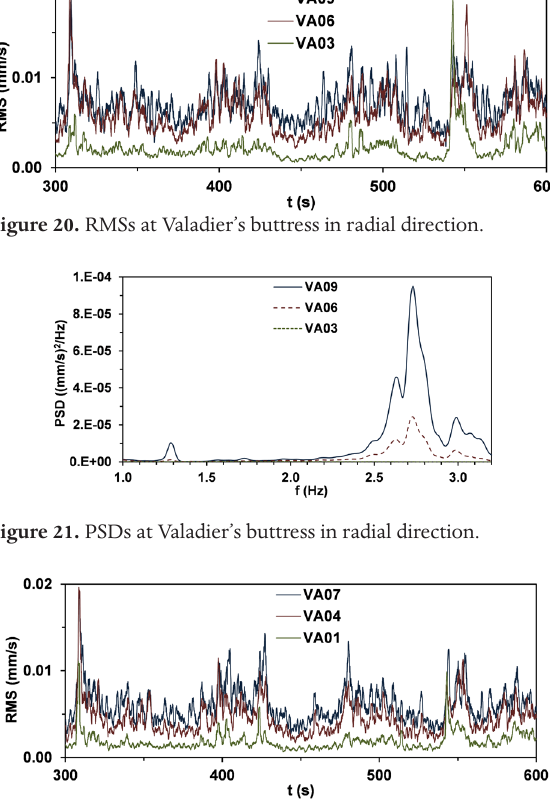
Figure 22. RMSs at Valadier’s buttress in tangential direction.